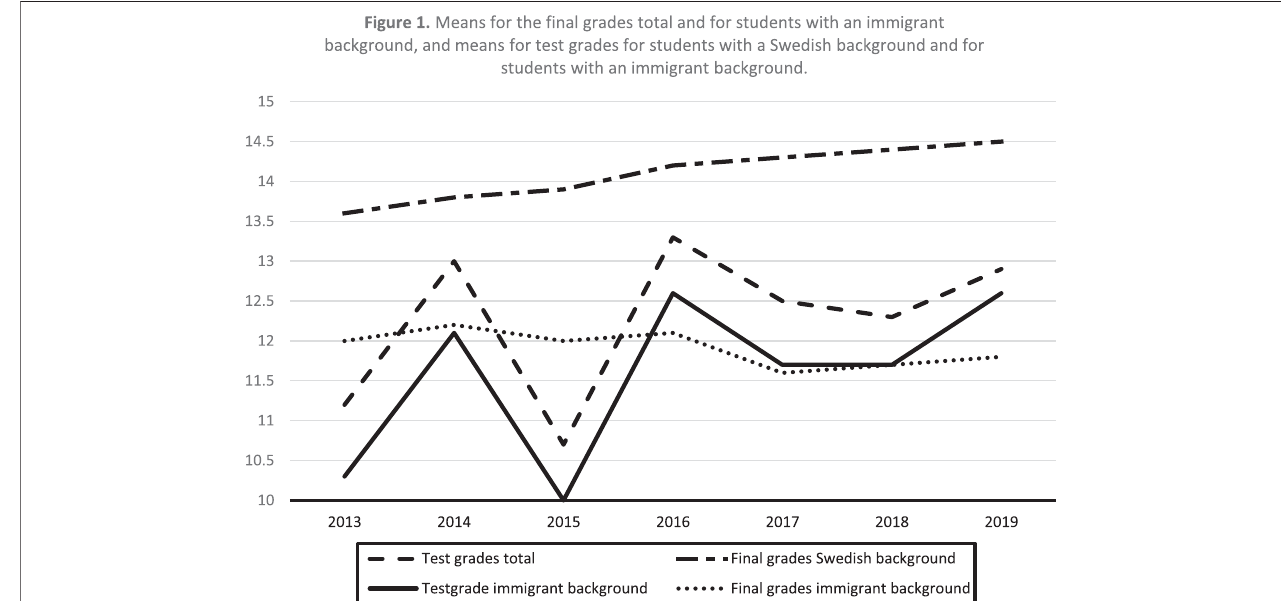
FIGURE 1 | Means for the fi nal grades total and for students with an immigrant background, and means for test grades for students with a Swedish background and for students with an immigrant background.